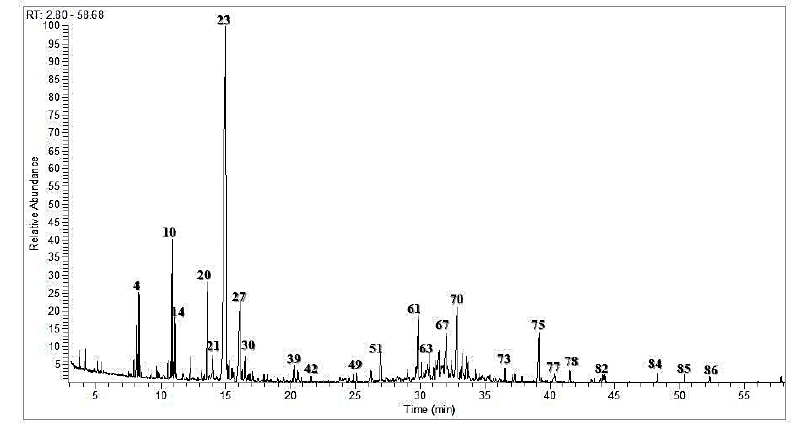
Figure 1. Gas Liquid Chromatography ( GLC) profile of the volatile constituents in the essential oil of C. indicum flower heads.